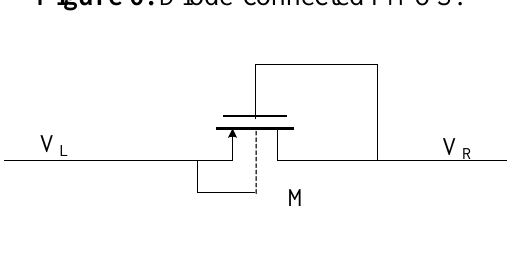
Figure 6. Diode-connected PMOS.